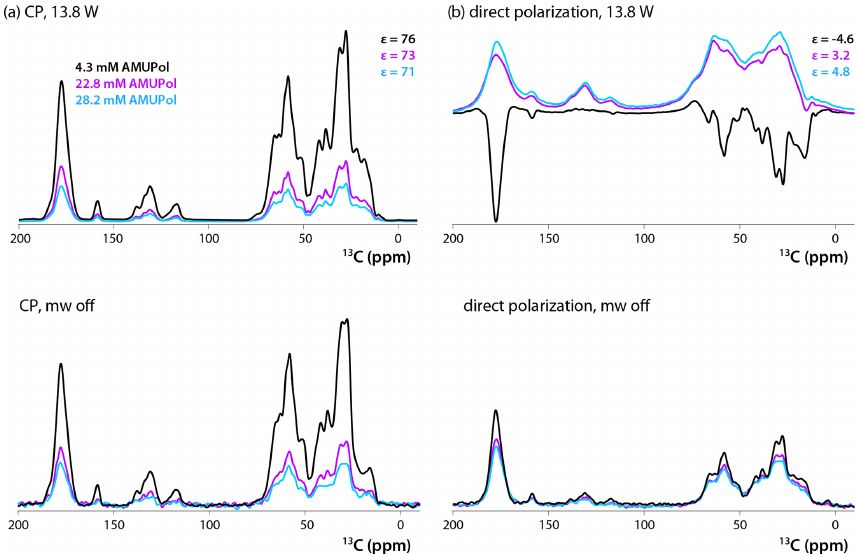
Figure 2. 13 C DNP-enhanced CP ( a , top), DNP-enhanced direct polarization ( b , top), CP ( a , bottom), and direct polarization ( b , bottom) MAS NMR spectra of 5F-Trp, U- 13 C, 15 N CA tubular assemblies in the presence of 4.3mM AMUPol (black traces), 22.8mM AMUPol (magenta traces), and 28.2mM AMUPol (blue traces). The non-DNP enhanced CPMAS spectra (bottom panels) are direct intensities. For DNP-enhanced spectra (top panels) signal enhancements are indicated. The spectra were acquired at 14.1T (150.96MHz 13 C Larmor fre- quency) at a MAS frequency of 24kHz and 120K. The recycle delay was 10s in all